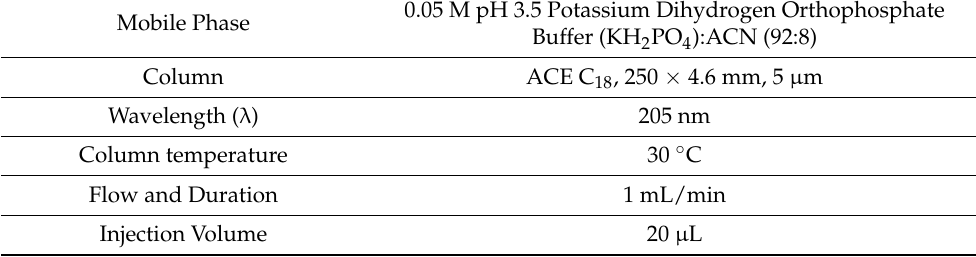
Table 1. Chromatographic